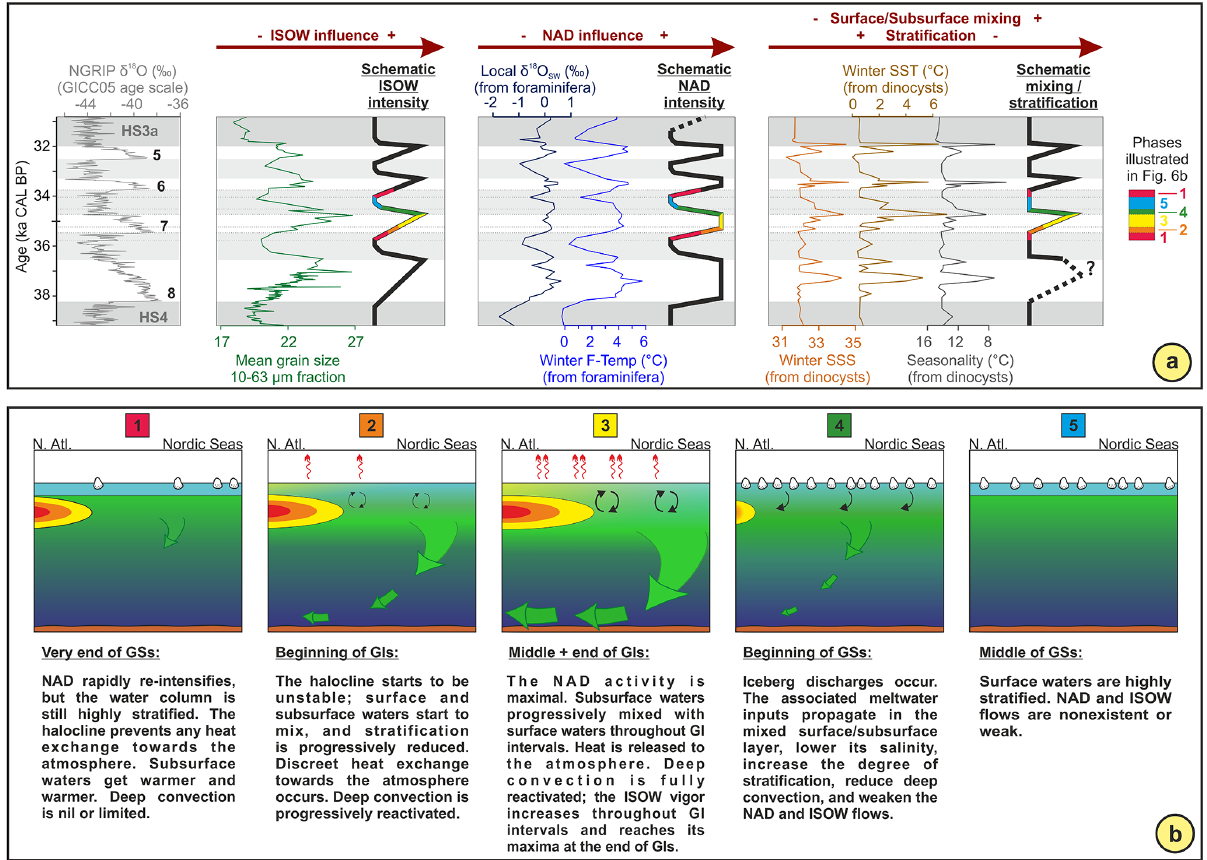
Figure 6. Synthetic figure illustrating the hydrological processes occurring during Dansgaard–Oeschger cycles at the study site. (a) Closeups of DO 8, 7, 6 and 5 showing the evolution of some selected proxies shown in Fig. 5, as well as the schematic evolution through DO cycles of the ISOW activity, the NAD vigor, the intensity of mixing between surface and subsurface waters, and the degree of surface stratification. (b) Conceptual representation of the hydrological processes occurring during the different phases of DO cycles as depicted in Fig. 6a.